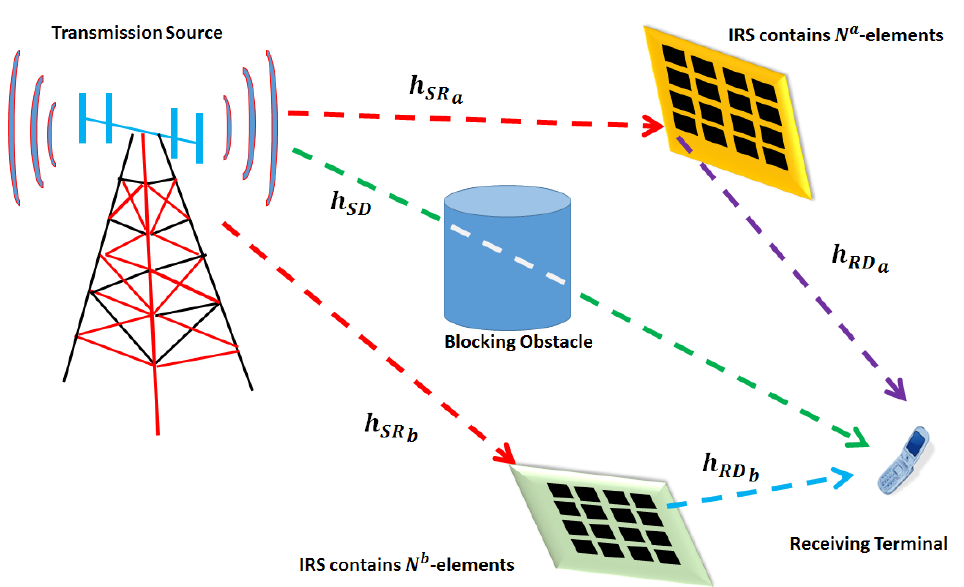
Figure 2. The proposed two IRS-assisted